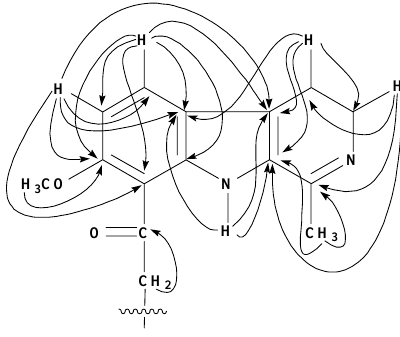
Figure 2. Significant HMBC ( 1 H (cid:198) 13 C) interactions of 12-acyl analogues of 1 .